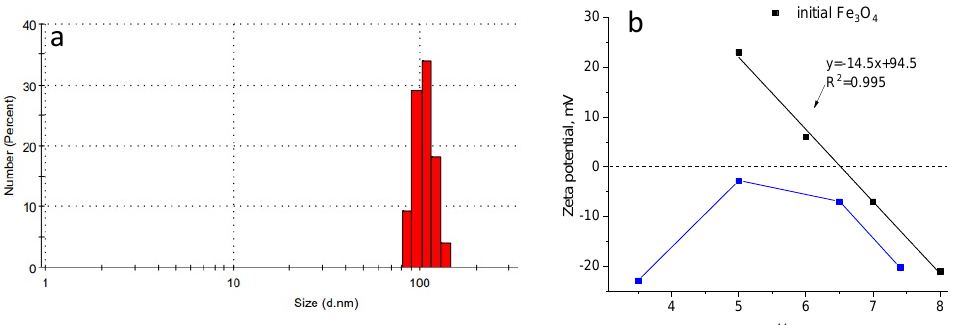
Figure 3. Size distribution of Fe3O4-TMSPM-PAA/PALAm-Gd-Carborane ( a ) and zeta-potential as function of pH ( b ).